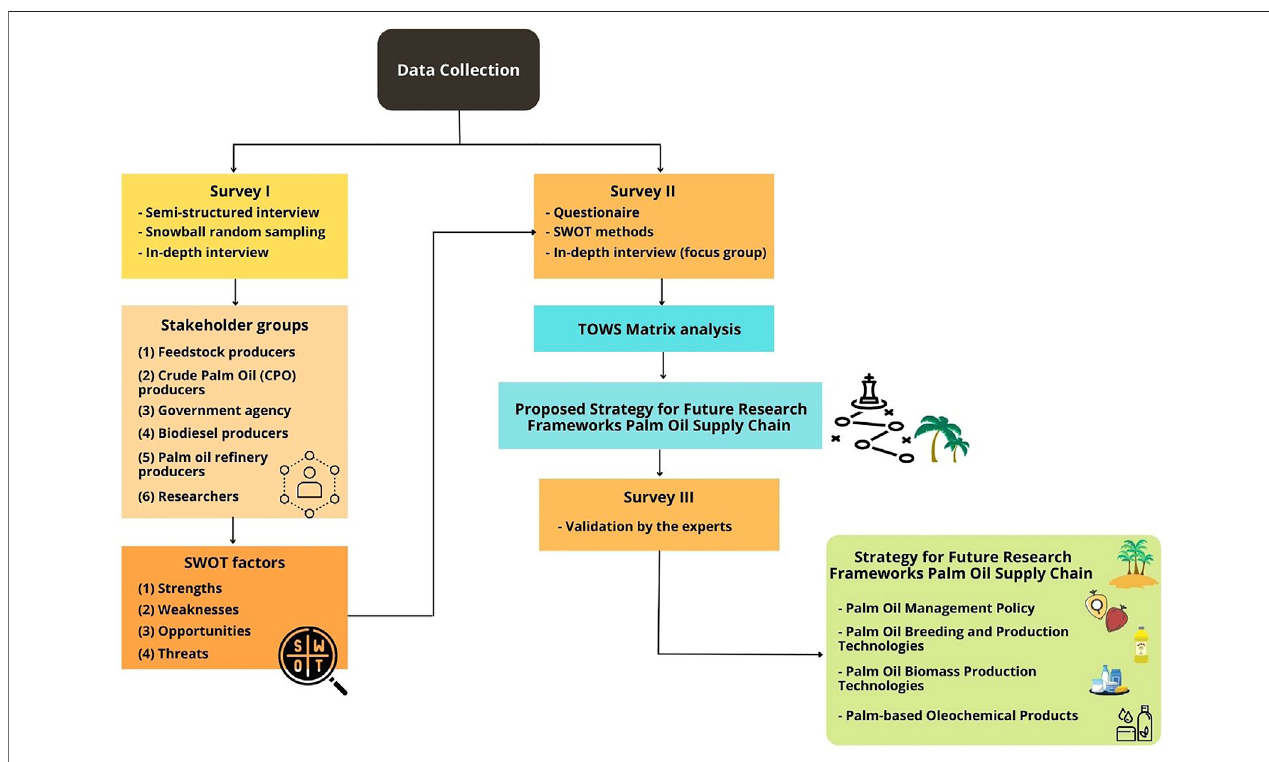
FIGURE 2 | Overview of the methodology in this